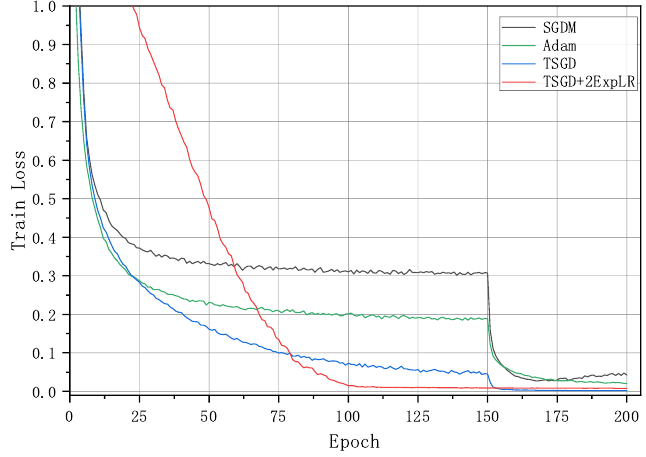
Figure 9. The loss of Cifar10-ResNet18 on the test